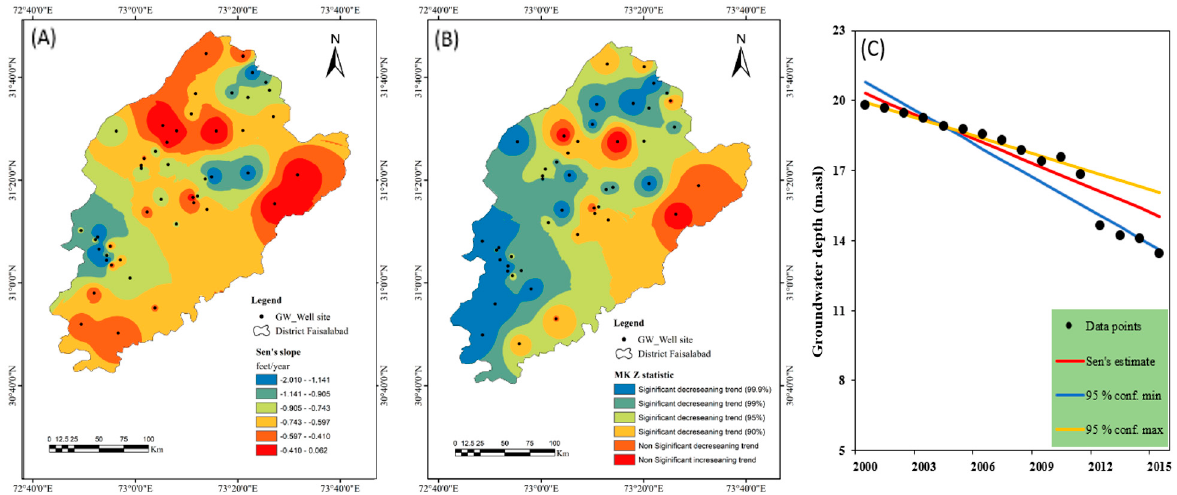
Figure 7. Spatial patterns of groundwater level were estimated using the Mann–Kendall test, showing Sen’s slop ( A ), Z statistics ( B ), and the annual average data points ( C ) from 2000 to